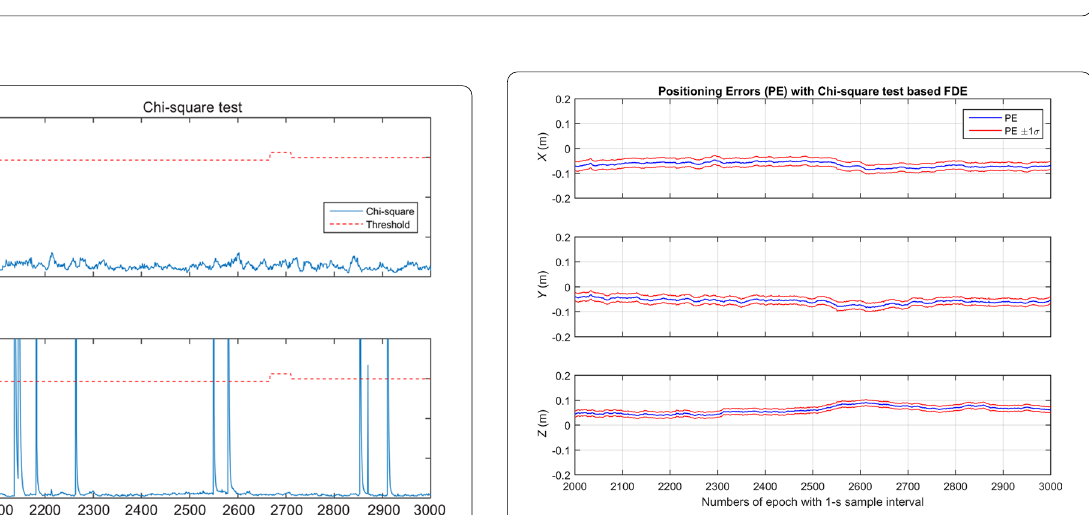
Fig. 6 PPP positioning errors (after convergence) with the Chi‑square test based FDE; P FA =